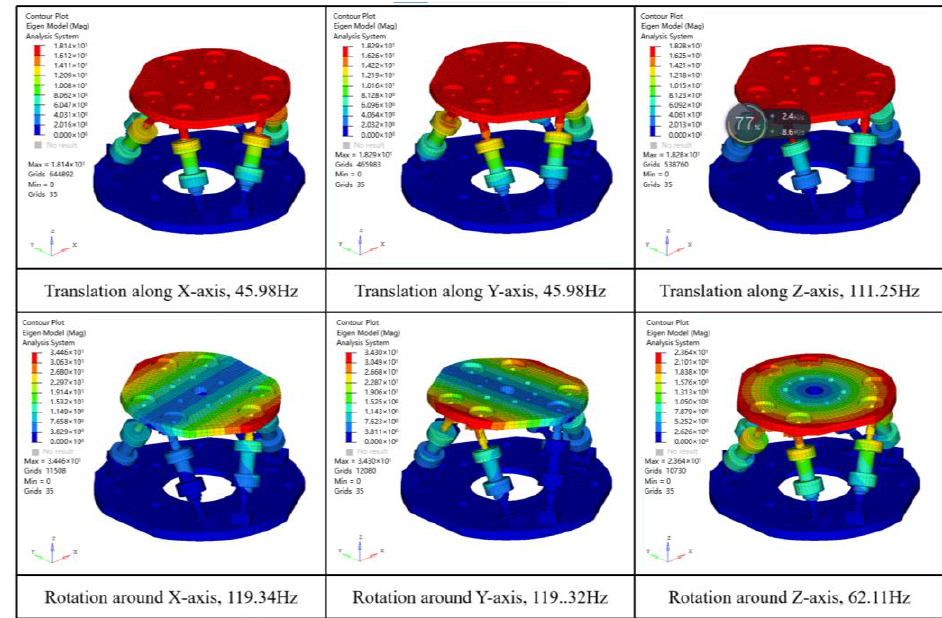
Figure 4. Modal analysis results of the Stewart platform prototype.